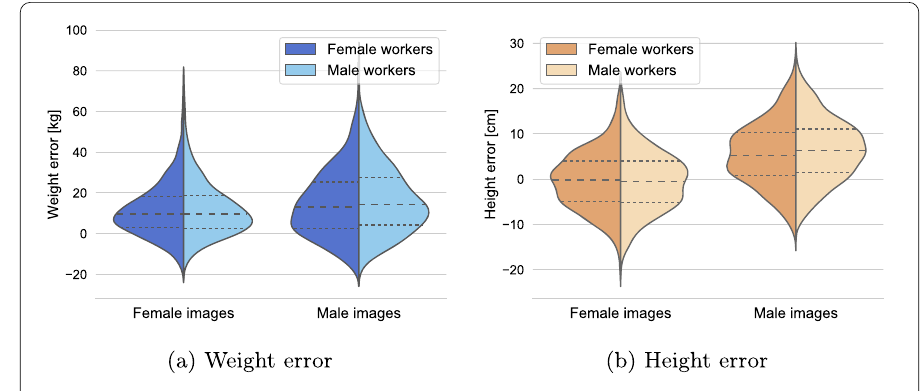
Figure 13 Dependence of estimation errors on gender of workers and images